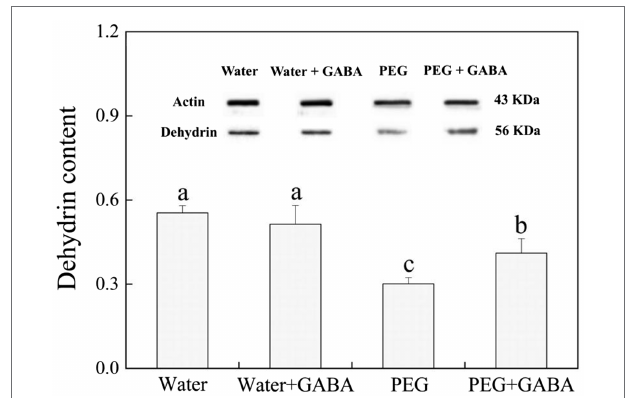
FIGURE 8 | Effects of seed priming with deionized water or γ -aminobutyric acid (GABA) on the abundance of dehydrins on the 7th day of germination in white clover under water stress.